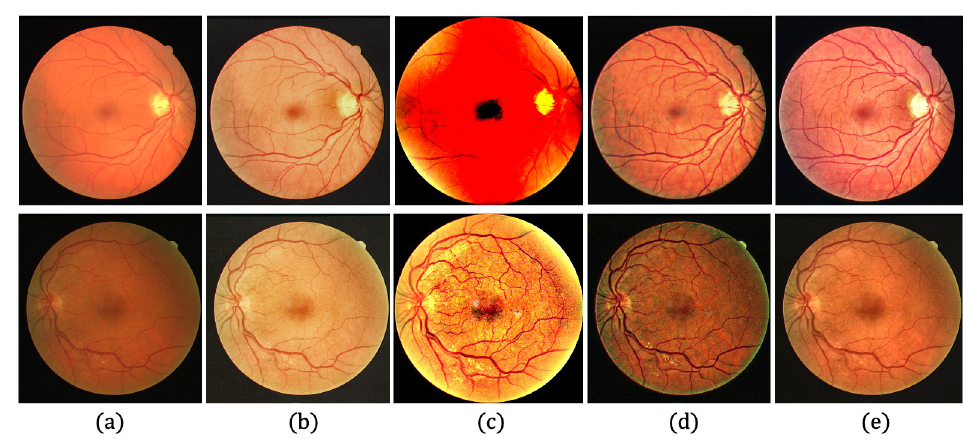
Fig 8. Qualitative comparison of two LQ image samples from the DRIVE database. (a) Input LQ images, and results using the methods of (b) Zhou et al. [42], (c) Gaudio et al. [88], (d) Dai et al. [89], and (e) the proposed method.